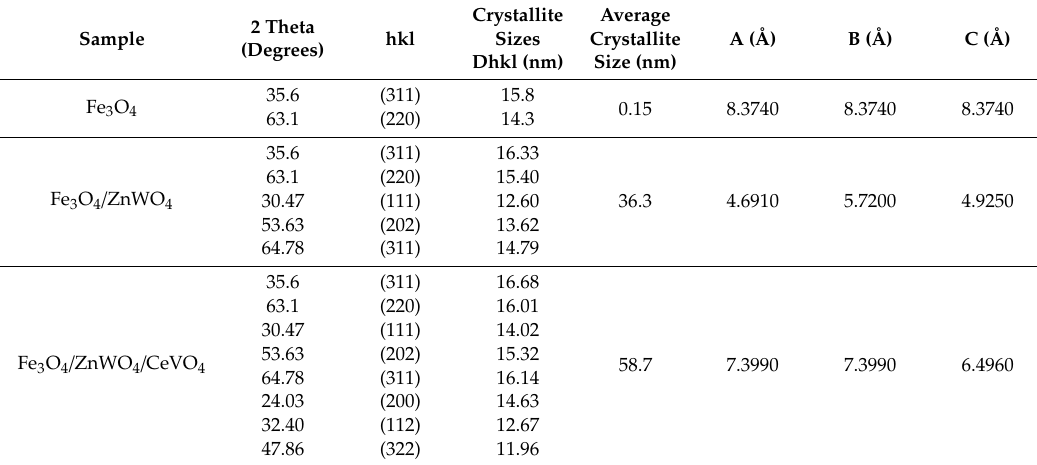
Table 1. Main reflections observed in the XRD patterns of inorganic nanoparticles.